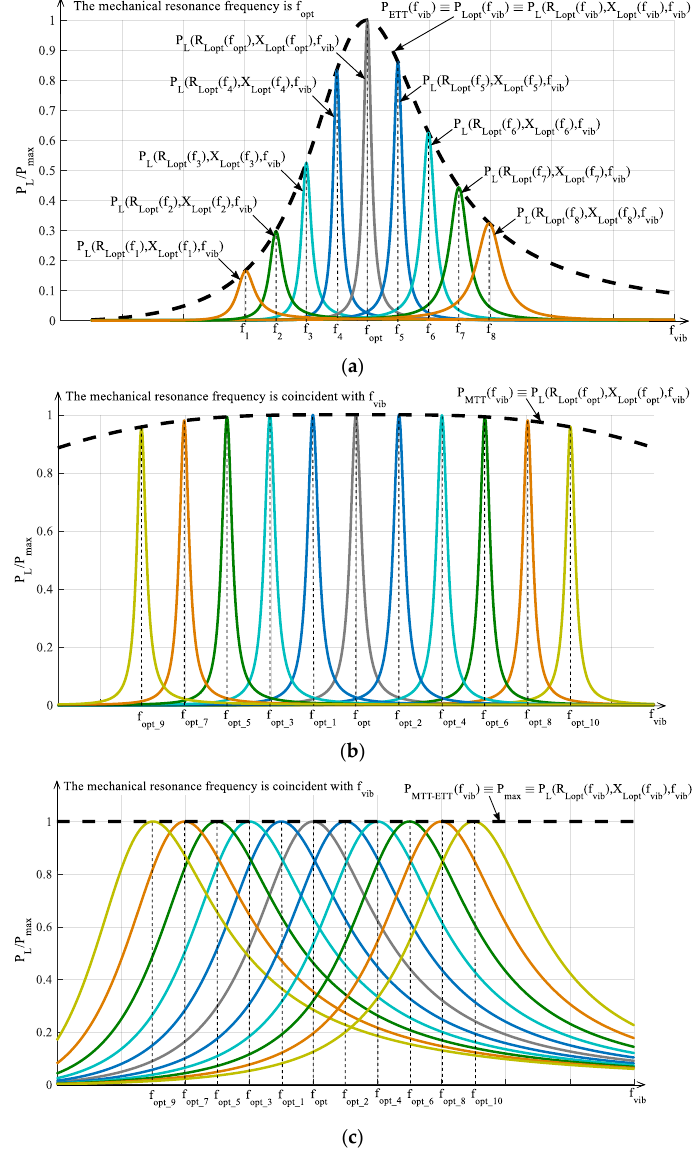
Figure 6. Typical trends vs. the normalized vibration frequency of the powers provided to the load by a RVEH (P-RVEH or E-RVEH) with the application of: ( a ) ETT, ( b ) MTT, ( c ) both ETT and